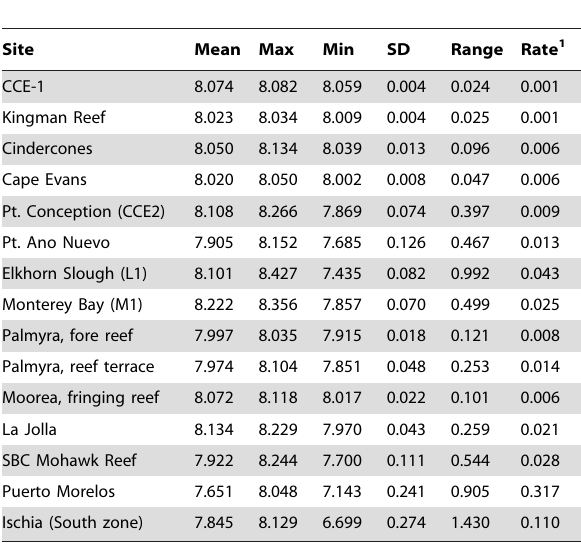
Table 2. Summary data for pH temporal profiles collected at 15 sensor